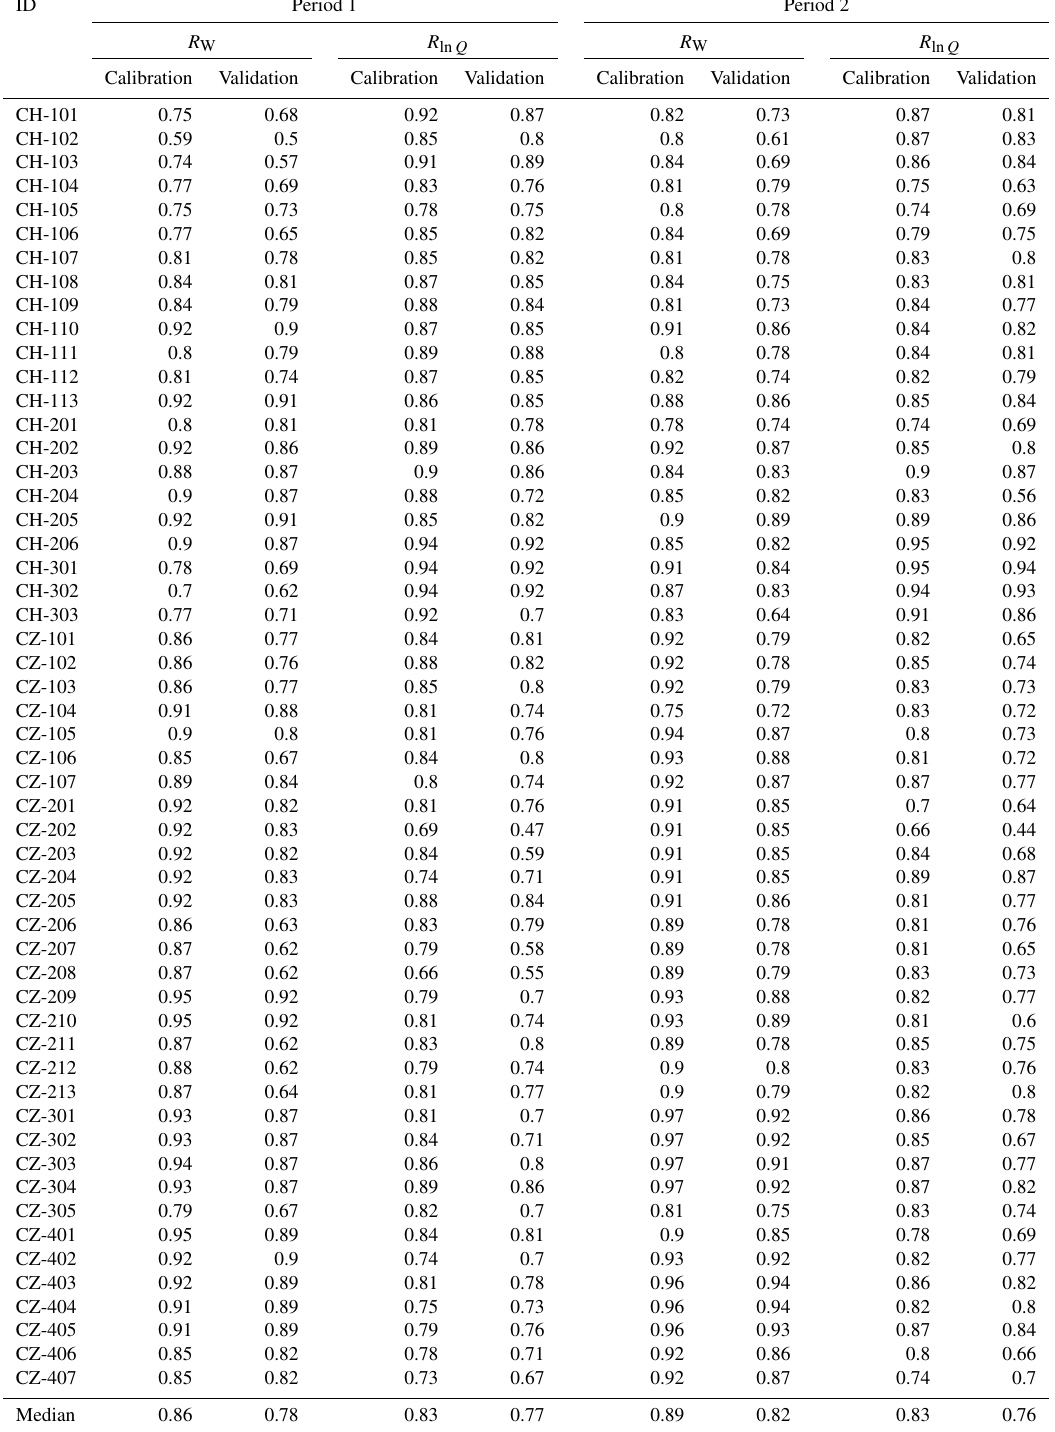
Table A1. HBV median calibration and validation performance values – both for snow water equivalent, R W , and logarithmic stream runoff, R ln Q – for each catchment and analysis